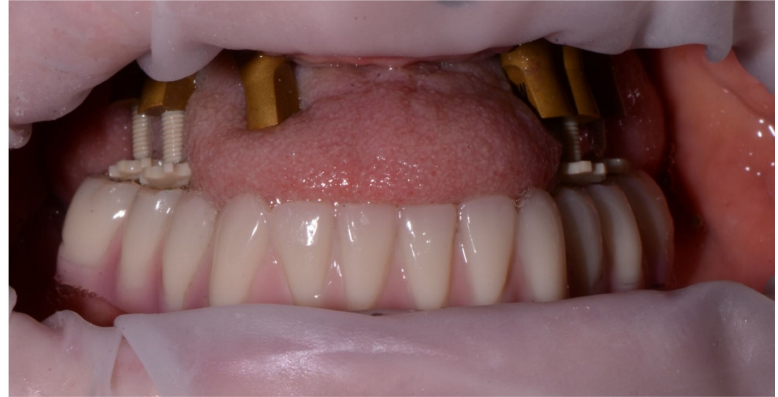
Figure 15. Female patient of 61 years old with severe crestal bone loss in the maxillary arch and voluminous tongue interposition. Long bite pillars are recommended to set the maxillary arch in the appropriate OVD to the mandibular antagonist arch.